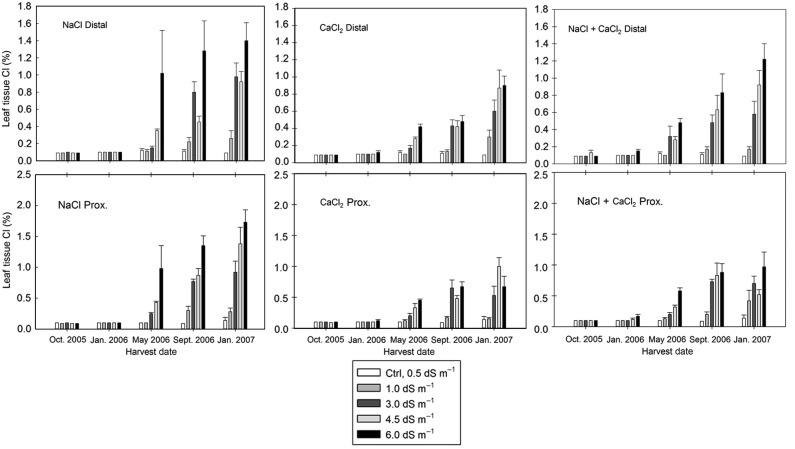
The rate of Cl− increase was relative to the salinity concentration rate in the irrigation solution, with the greatest tissue concentrations in the plants in treatment groups with the greatest ions. The % Cl− concentration did not differ greatly between distal and proximal ends of the leaf for any treatment combination. The Cl− concentration did not initially increase (October 2005–January 2006). However, subsequent harvests exhibited increasing concentration of Cl− ions in the leaf tissues.